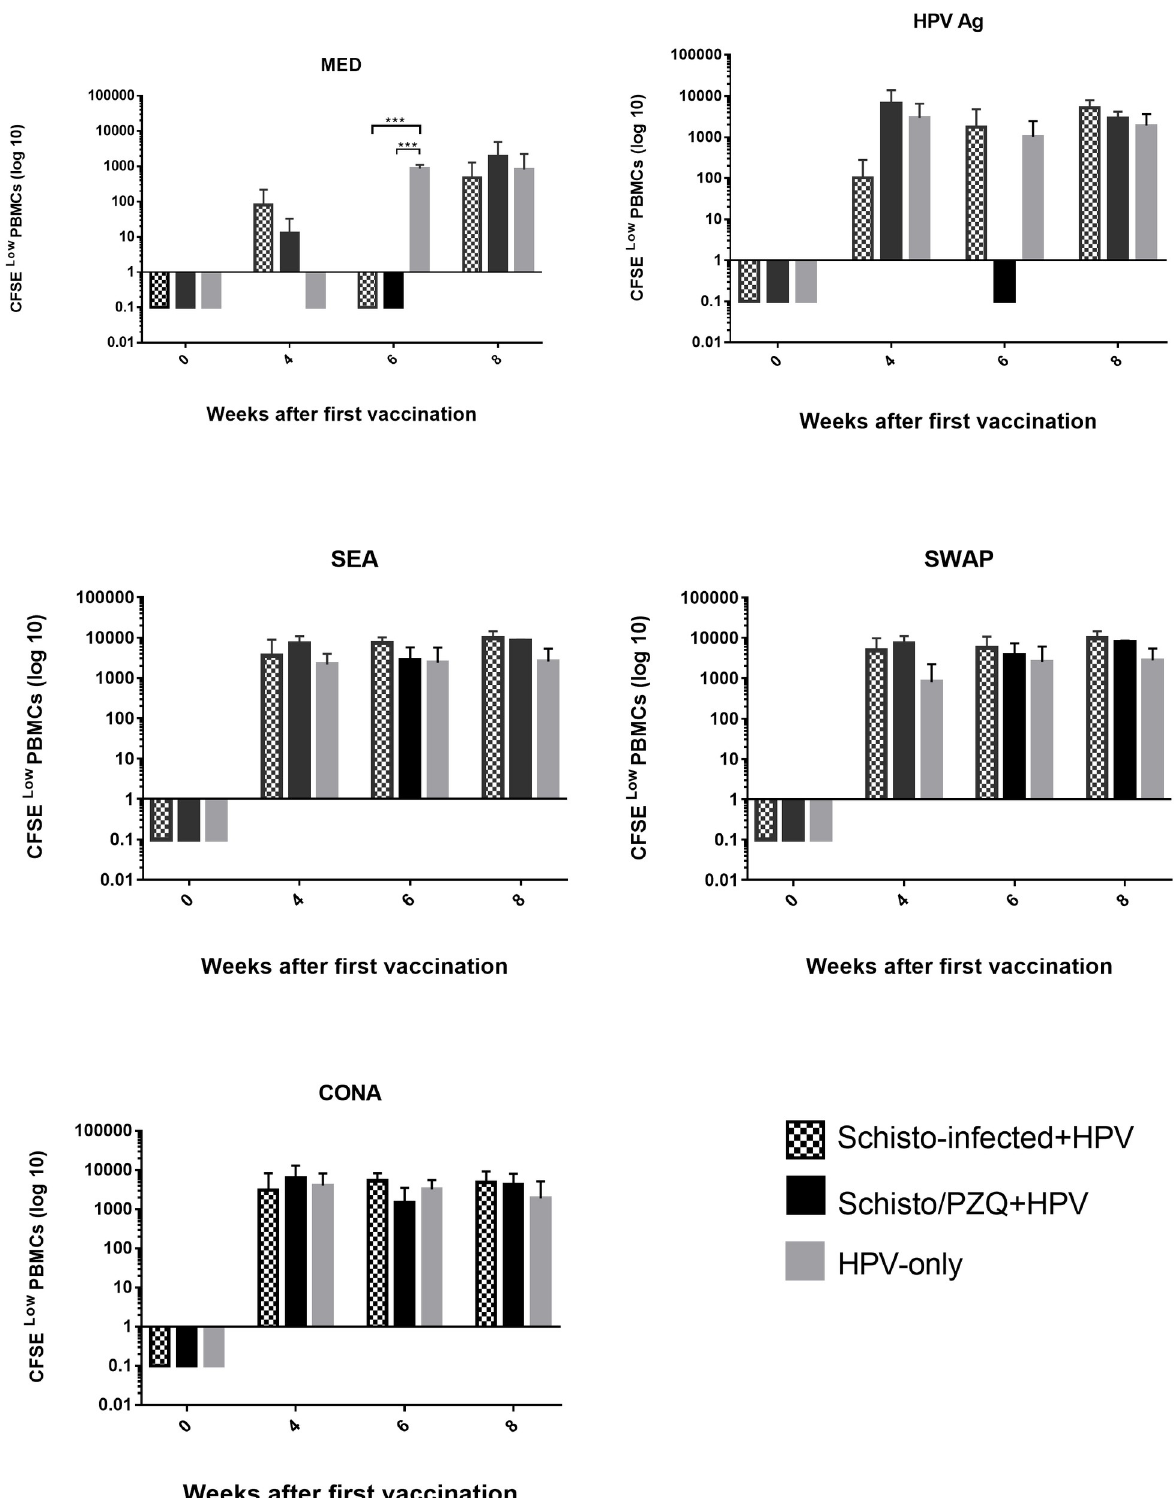
Fig 5. CFSE low PBMCs. Illustrates the average number of cells that have lost any level of CFSE labelling after 72 hours in culture during specific (HPV, SEA and SWAP), non-specific stimulation (CONA) and absence of stimulant (MED) in Schisto-infected+HPV, Schisto/PZQ+HPV and HPV-only (Control) groups. PBMCs were collected from the 3 groups at 4 time points; Week 0 (pre-vaccination), Week 4 (4 weeks after the 1